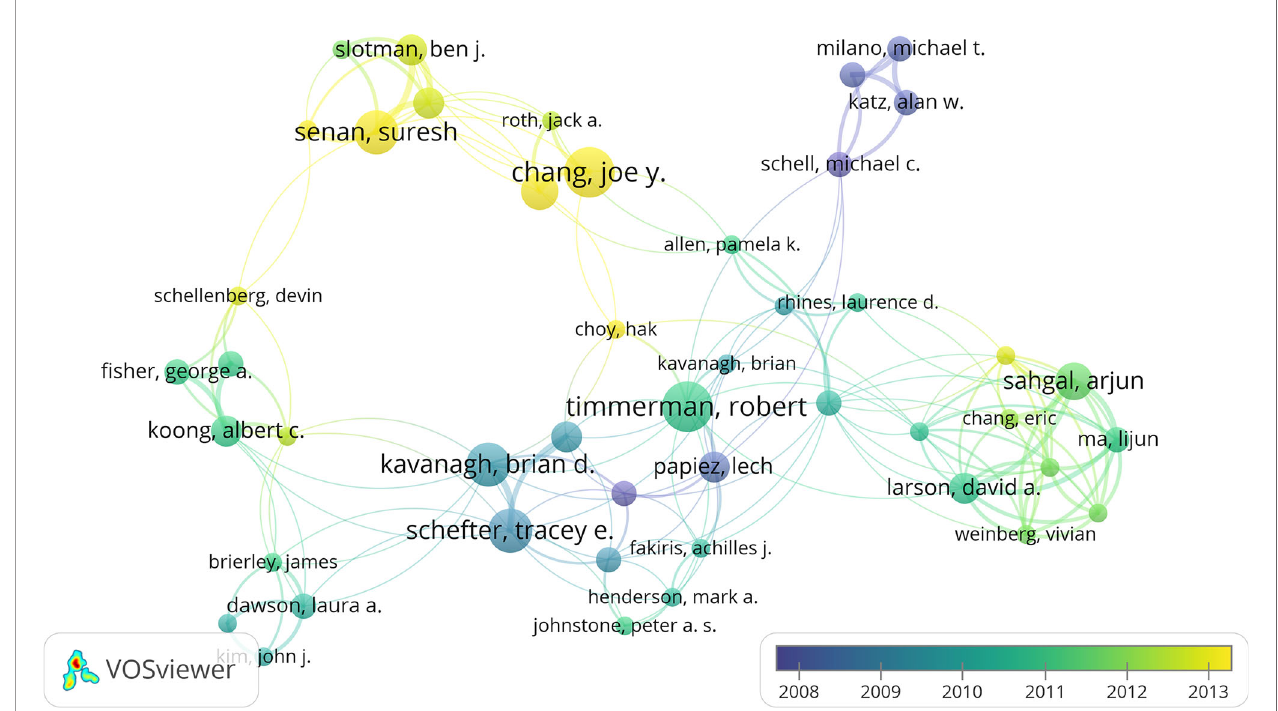
FIGURE 4 | The network visualization of co-authors from the 100 most cited articles according to the average published year. The circle size represents the number of articles in the 100 most cited articles. The width of the curved line represents the link strength. The distance between 2 authors approximately indicates the relatedness of the